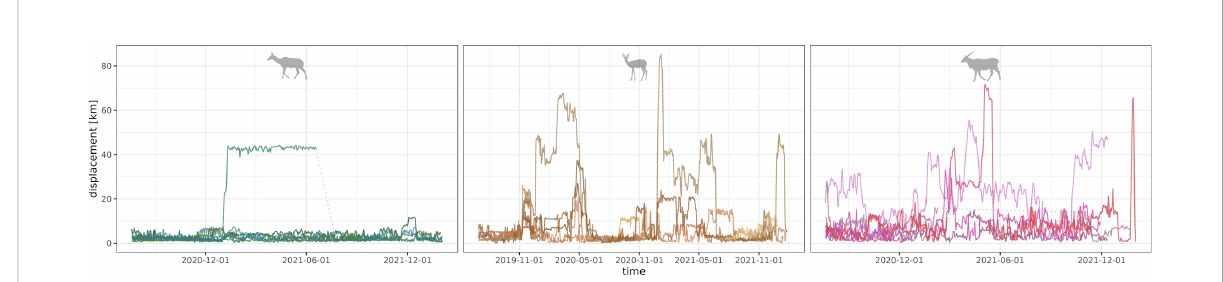
FIGURE 2 Overview of the individuals ’ GPS-based movement patterns. Within species-wise panels (from left to right: kudu, springbok, eland) displacement is shown on the y -axis, measured as distance in km to the most visited waterpoint, along the observation time ( x -axis, note the differing observation times). Individual patterns are shown in different